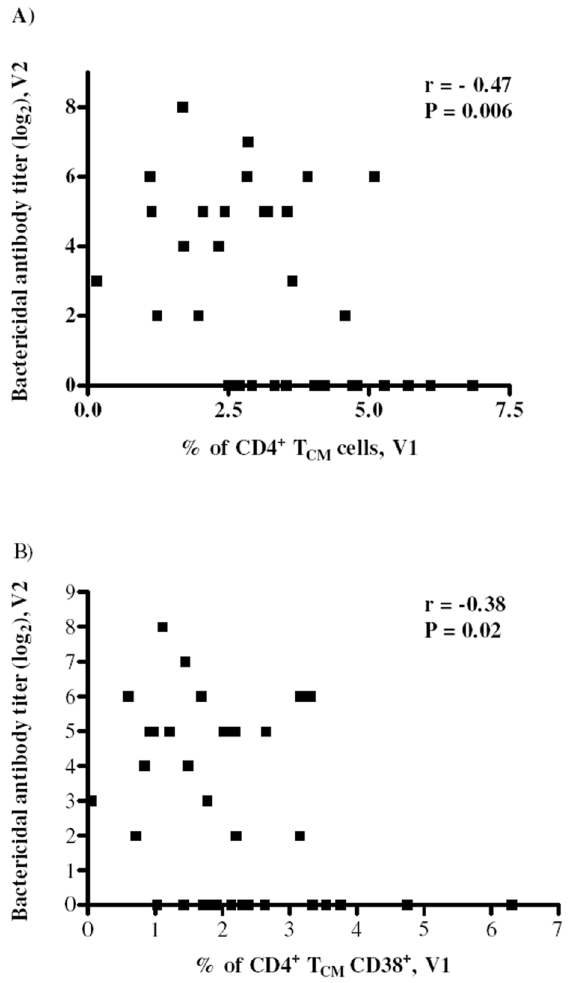
Fig. 4. CD4 + T CM memory subset correlates negatively with bactericidal antibody titers. Negative correlation between the frequency of CD4 + T CM cells (A) and CD4 + T CM cells expressing CD38 (B) before vaccination (V1) with post-vaccination bactericidal antibody titers (V2). Correlations were analyzed using Sperman rank test.